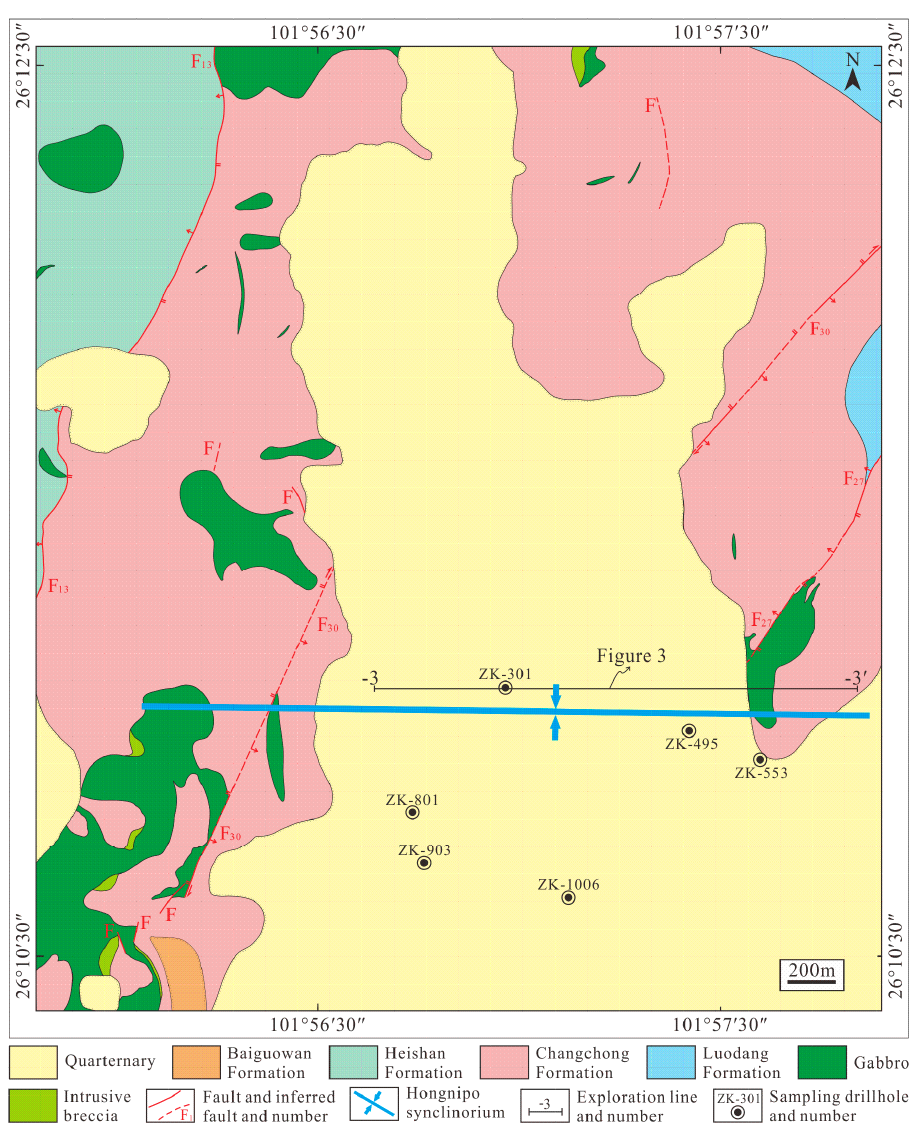
Figure 2. Geological sketch map of the Hongnipo Copper deposit (modified after [26]).